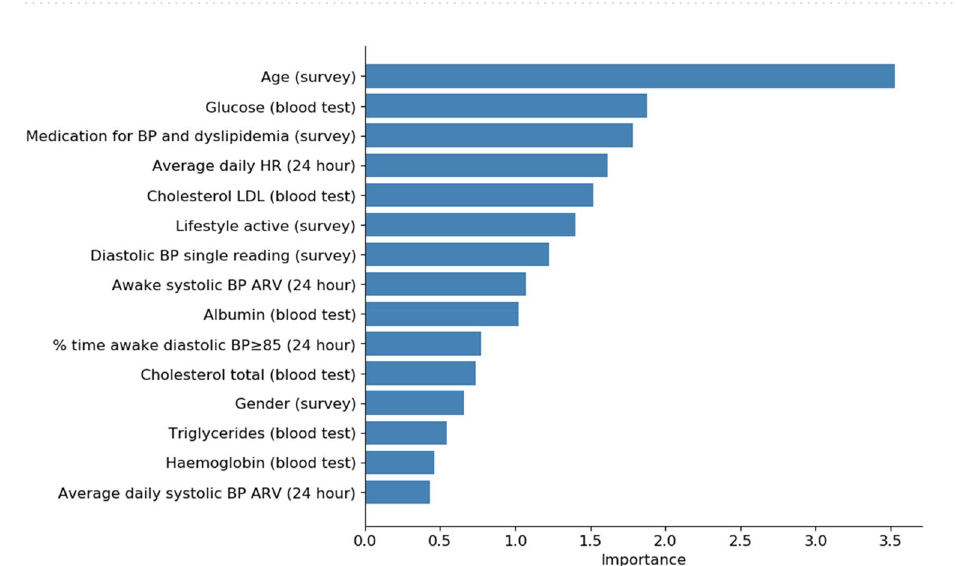
Figure 2. ROC curves for low risk group (left) and high risk group (right). Colours and line style represent the prediction performance for different models. Prediction performance for both low and high risk groups were significantly better in model 5* compared to FRS.